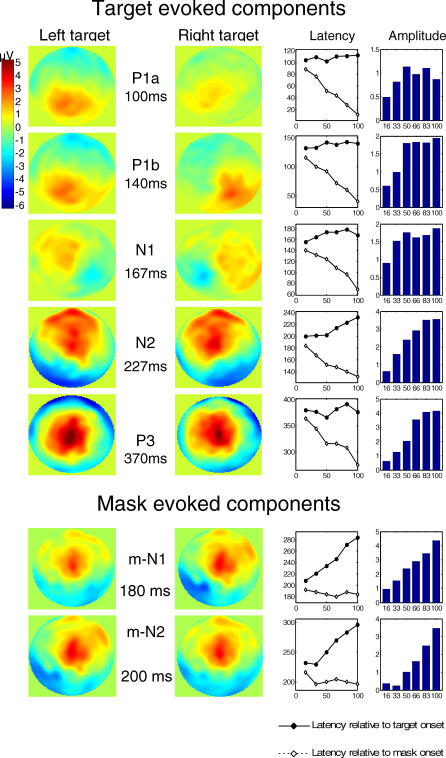
Sequence of ERP Components Evoked by the Target and MaskFive ERP components were found to be elicited by the target, and two other components were found to be evoked by the mask. These two last components appeared as positive waveforms since they result from the subtraction of mask-only activity from the mask-evoked N1 and N2 activity for the different target + mask conditions. In the mask-subtracted data, these components appear to increase with SOA, which in reality means that the mask-induced activation (mask-evoked N1 and N2) decreases with SOA.For each component, its peak latency (in milliseconds) is represented as a function of SOA measured relative to target (continuous line) or to mask onset (dashed line). The histograms at right show peak amplitude (in microvolts).Their topography in response to left and right hemifield stimulation is illustrated by voltage maps of the scalp surface, for the target + mask after mask subtraction, SOA=100 ms (first five target-evoked components) and for the mask-only condition (for mask-evoked N1 and N2 components).